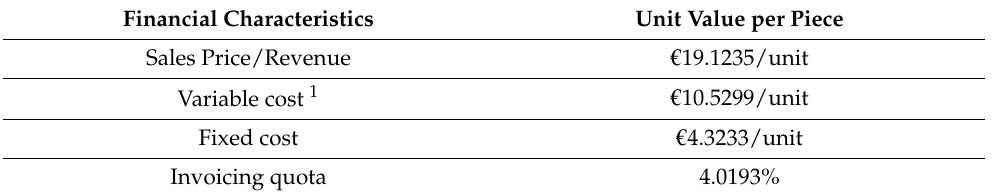
Table 12. Financial characteristics of the